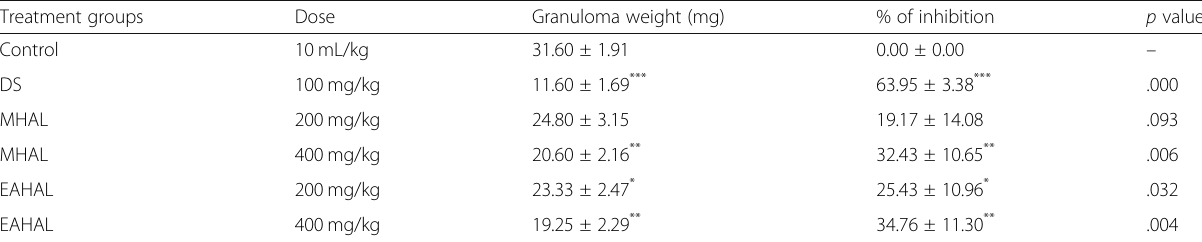
Table 3 Effect of standard and MHAL and EAHAL on cotton pellet induced granuloma formation test Treatment